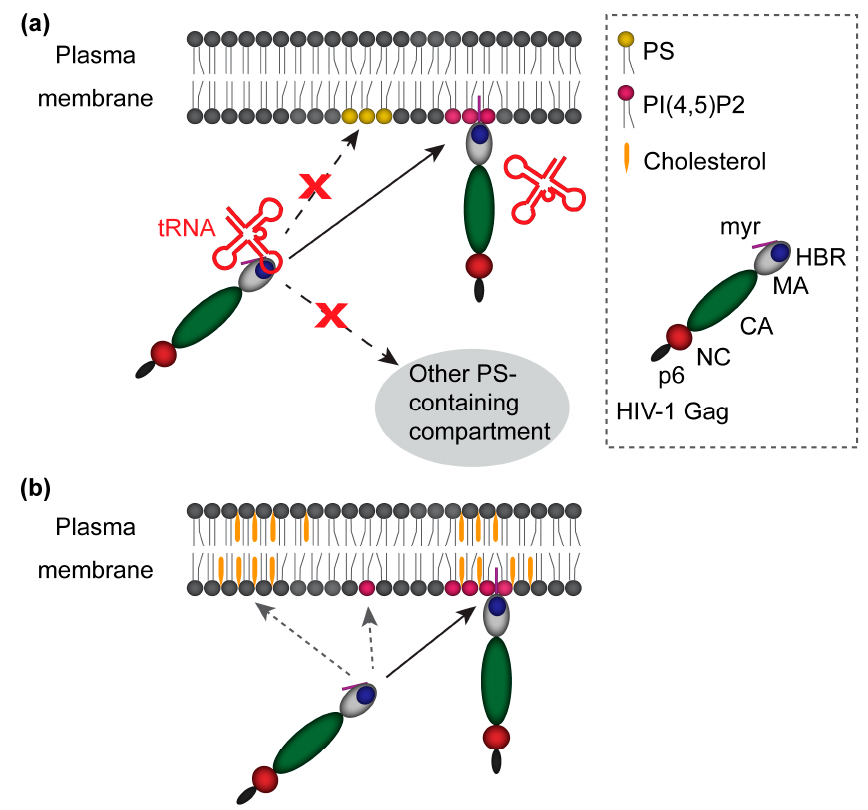
Figure 2. Regulation of Gag binding to the plasma membrane (PM). ( a ) Interactions of Gag with PI(4,5)P2 and tRNA ensure specific localization of Gag to the PM. Binding of Gag to tRNA prevents localization of Gag to intracellular membranes that contain PS but not PI(4,5)P2. Interaction of Gag with PI(4,5)P2-containing membrane overcomes the block on membrane binding by tRNA, thereby recruiting Gag to the PM; ( b ) cholesterol-dependent membrane binding by Gag. Cholesterol increases the membrane binding of Gag, including binding to PI(4,5)P2-containing PM.